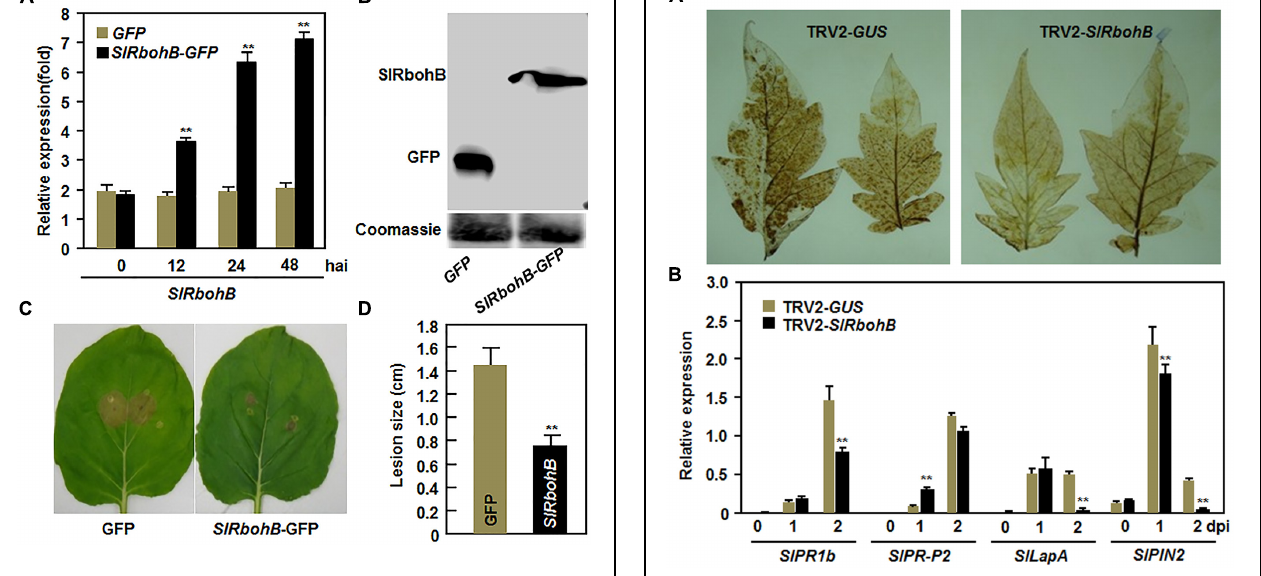
FIGURE 6 | Silencing of SlRbohB attenuated B. cinerea -induced defense response. Two-week-old plants were infiltrated with agrobacteria harboring TRV2- SlRbohB or TRV2- GUS and the leaves were inoculated by dropping spore suspension (1 × 10 5 spores/mL) at 4 weeks after agroinfiltration. (A) Accumulation of H 2 O 2 and (B) expression of the selected defense genes. Accumulation of H 2 O 2 was detected by DAB staining at 24 h after inoculation. Expression of the defense genes was analyzed by qRT-PCR and relative expression was shown as folds of the transcript levels at different time points vs. the corresponding values at 0 h after inoculation. Data presented in (B) are the means ± SD from three independent experiments and ∗∗ above the columns indicate significant difference at p < 0.05